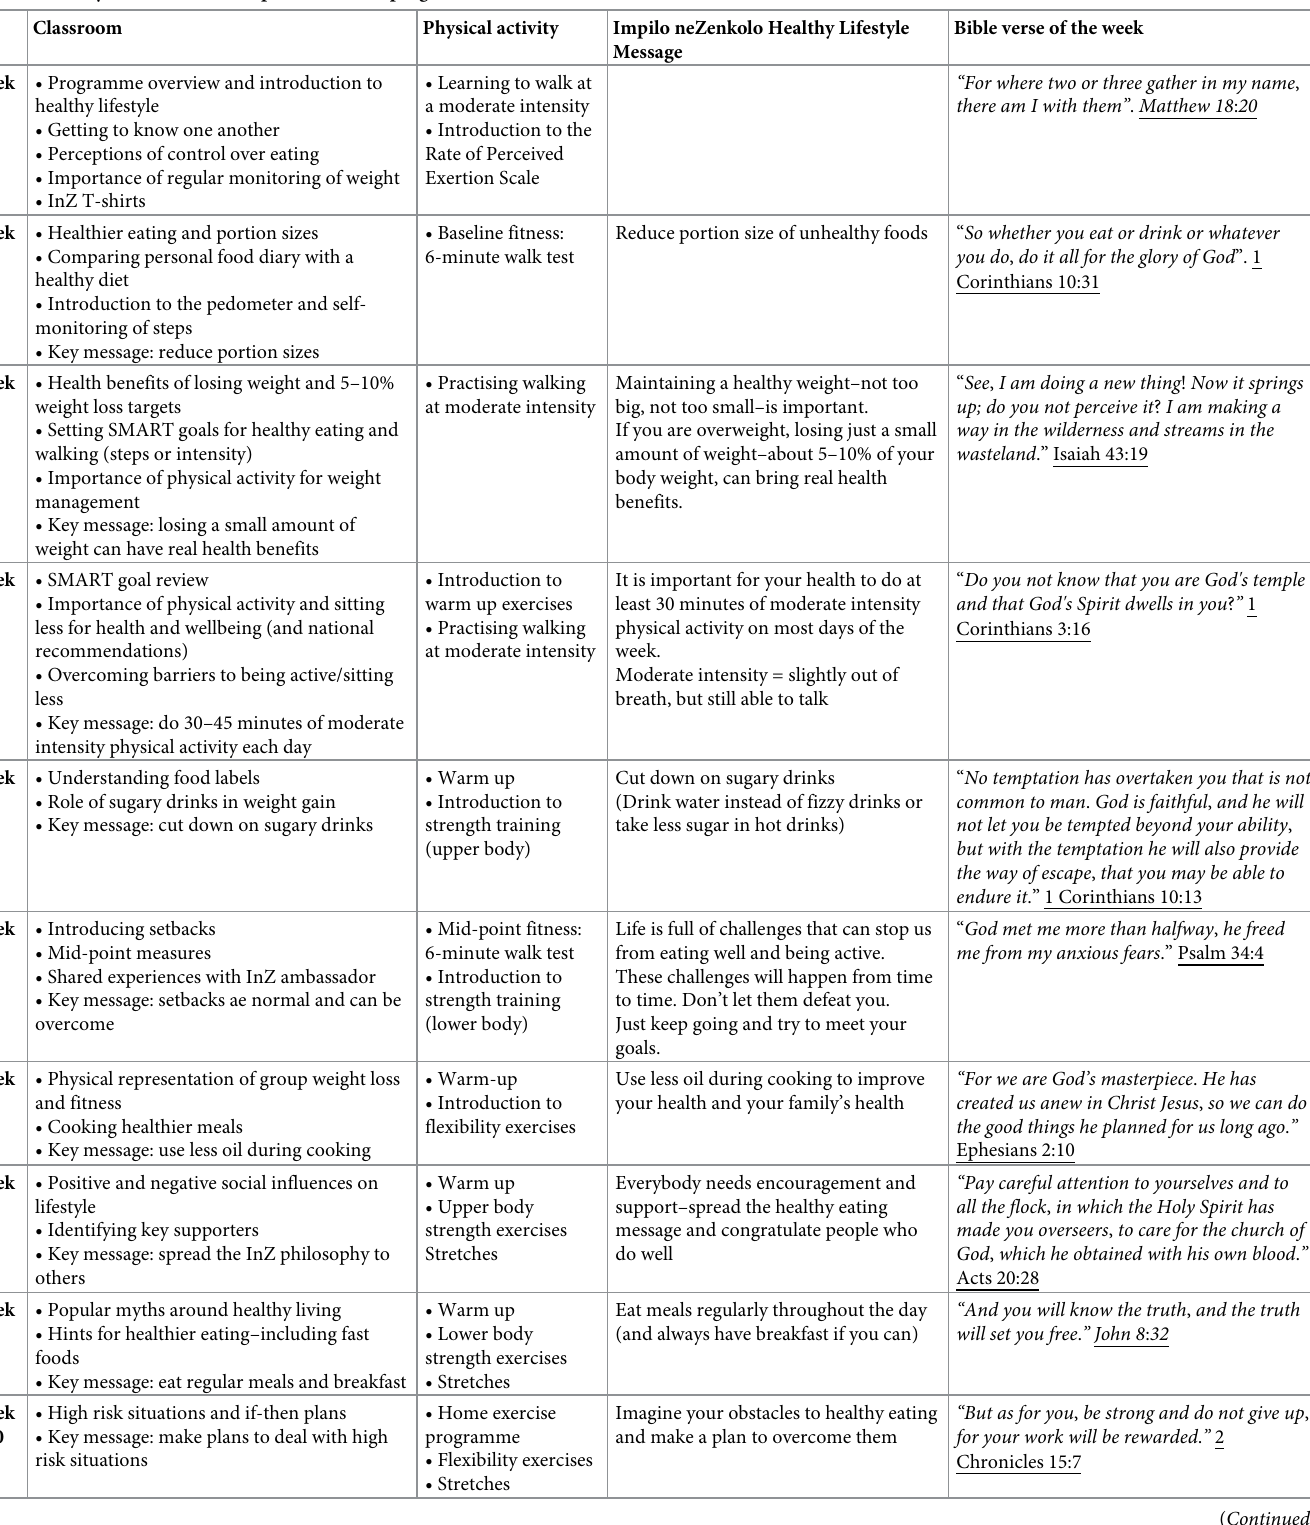
Table 2. Weekly content for the Impilo neZenkolo